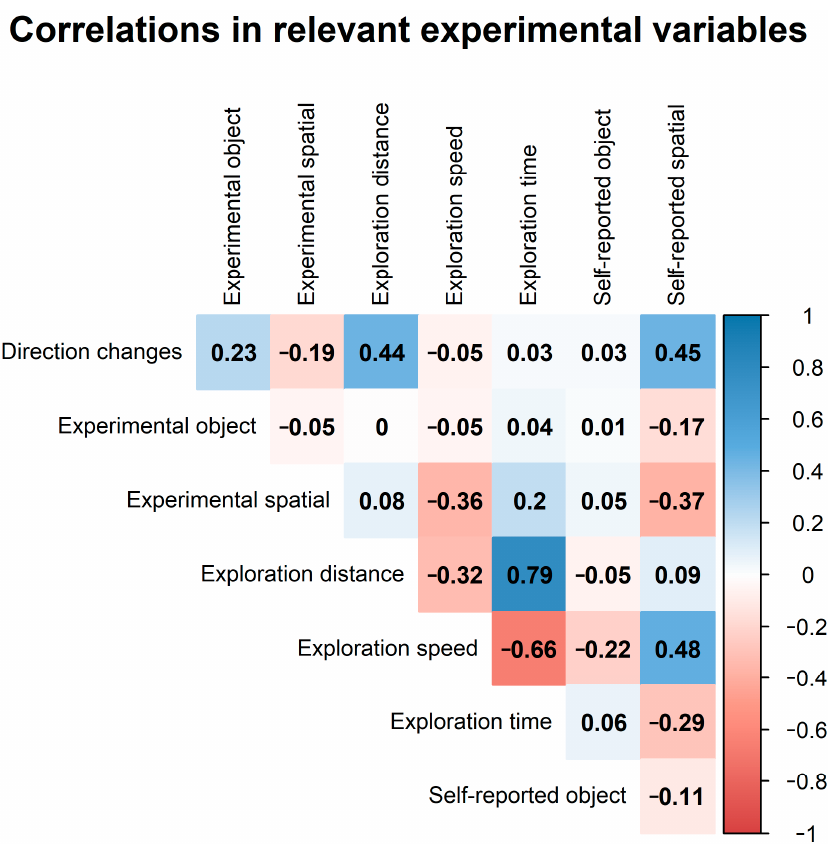
Figure 9. Correlations in relevant experimental variables. Color represents the correlation direction, color intensity is correlation strength, p -values are in squares (rounded to two decimals).